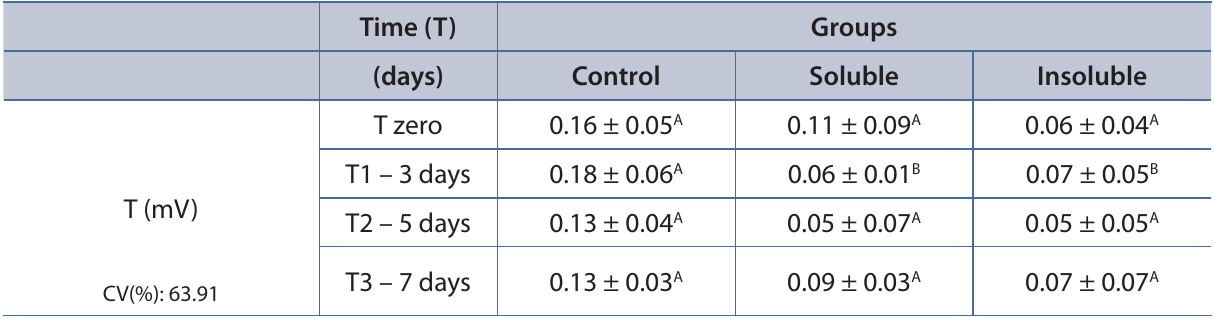
Table 5. T wave mean amplitude (mV) in rabbits submitted to gavage with ultra-pure water (CG), water- soluble A. rigida extract (SG) and water-insoluble A. rigida extract (IG) at different